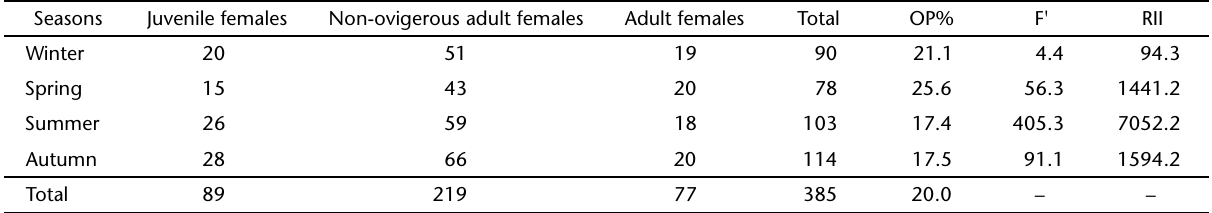
Table II. Relative fecundity (F’), reproductive intensity index (RII) and percentage of ovigerous females (OP) by season of U . rapax from Itaipu Lagoon. Seasons